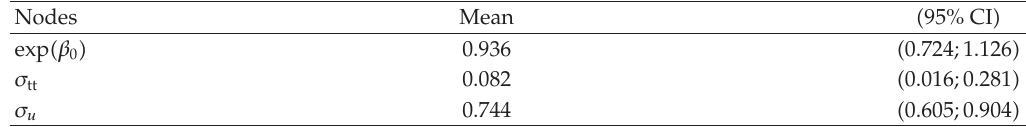
Table 4: Posterior mean estimates of the parameters from model